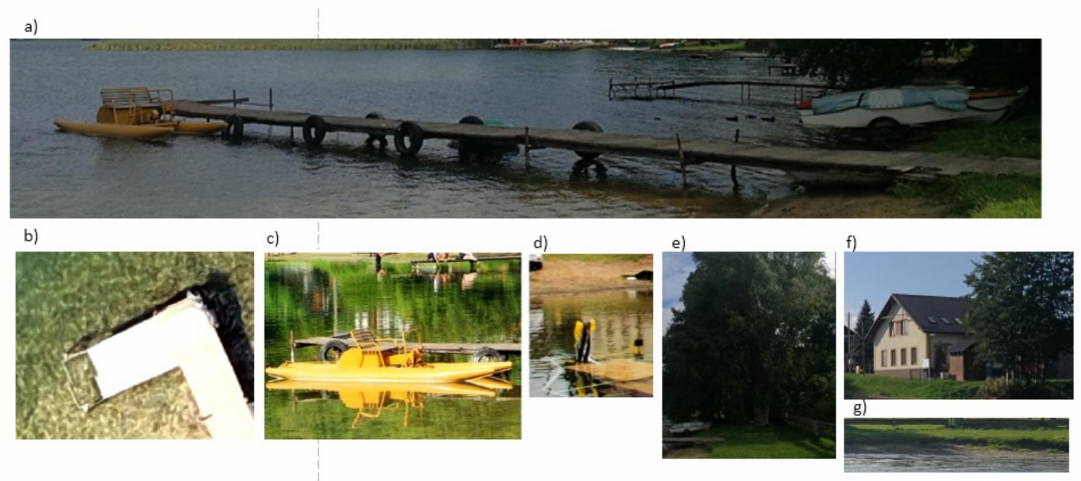
Figure 8. Objects selected for the study: ( a ) wooden jetty; ( b ) metal structure on wooden jetty; ( c ) paddle boat; ( d ) metal component of trailer; ( e ) trees; ( f ) building and trees; ( g ) sandy shore.